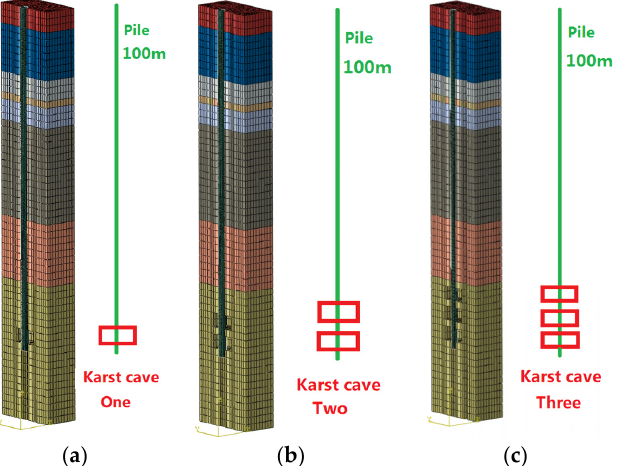
Figure 7. Schematic diagram of the finite element model of the rock-socketed pile with different karst caves. ( a ) Single-beaded karst cave, ( b ) double-beaded karst cave, and ( c ) three-beaded karst cave.